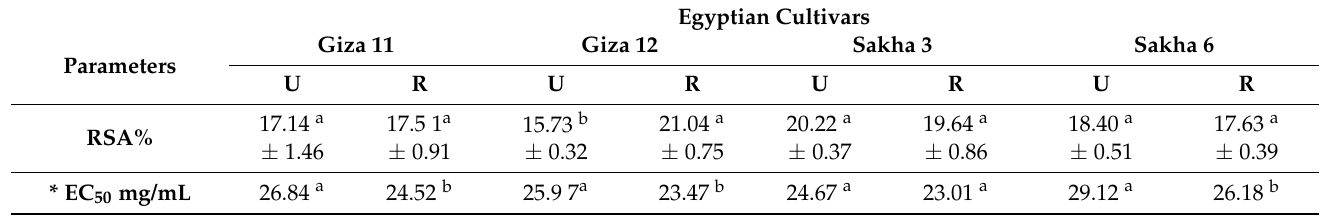
Table 7. EC 50 mg/mL (calculated from DPPH scavenging activity) and radical scavenging activity (RSA%) of linseed oil extracted from four unroasted and roasted Egyptian linseed cultivars. Egyptian Cultivars Giza